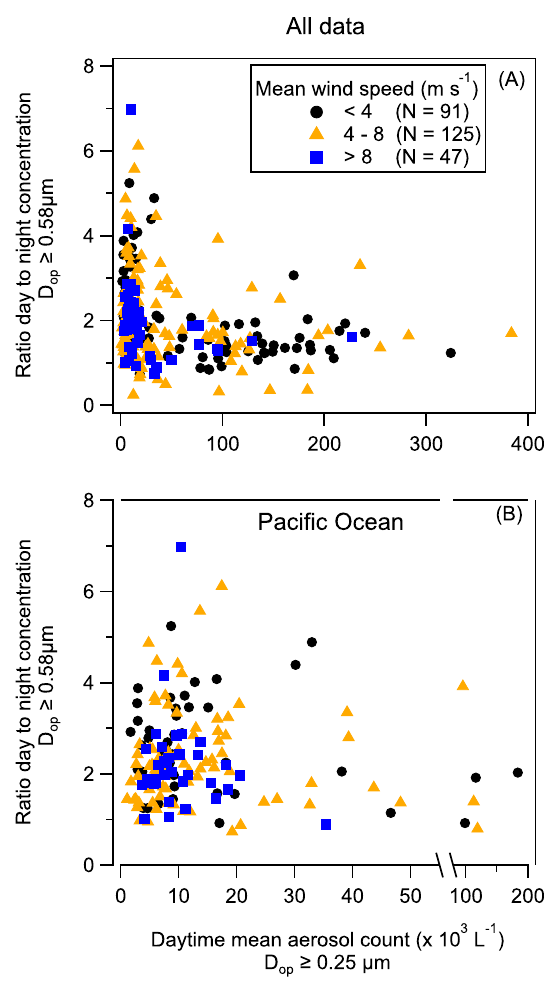
Fig. 6 Day-to-night changes of the sea spray aerosol number concentration with optical diameters ( D op ) ≥ 0.58 μ m (N SSA ≥ 0.58 µ m ) and the rate of change of γ ( ∂ γ / ∂ t (hr − 1 )). A Box plot analysis of the 282 days with the 24-h cycle in the Paci fi c Ocean shows the compelling statistical signi fi cance of the day and night counts. B Box plot analysis of the γ rate of change (vertical axis inverted) for the 167 days (near the Paci fi c islands, Japan, and Taiwan there is no data). Statistically signi fi cant day to night variation is readily discernible. The box plots show the median, and the 5th, 25th, 75th, and 95th percentiles; the orange line is the mean. N refers to the number of days